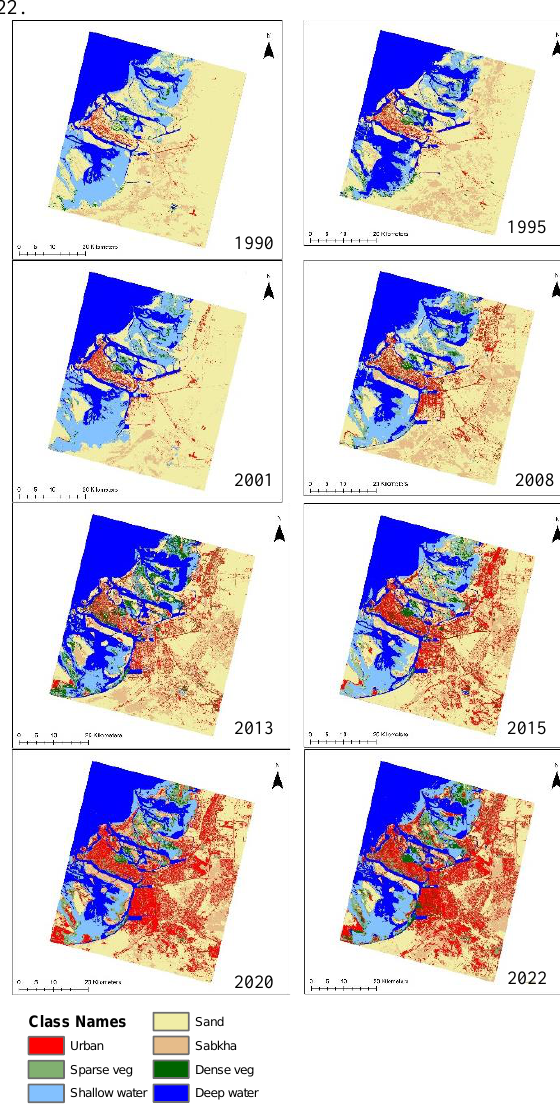
Figure 3. LULC maps of the study area for the years 1990, 1995, 2001, 2008, 2013, 2015, 2020, and 2022. Urban land in the study area is increasing while sand and sabkha are decreasing. Numerous factors contribute to the urban sprawl of AD city. The prominent factors include population growth, economic development, and government policies (Taileb et al., 2008). Multitemporal analyses of LULC provide insight into long-term trends and help identify future determinants of change.